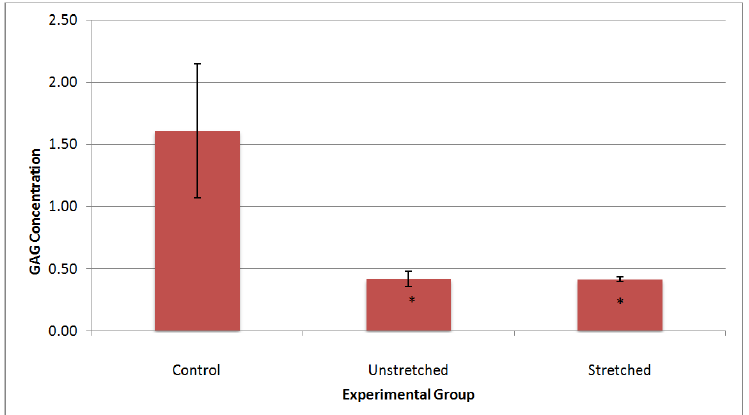
Figure 9. GAG deposition normalized to DNA (ngGAG/ngDNA). n = 5. * Statistically different than control ( p <